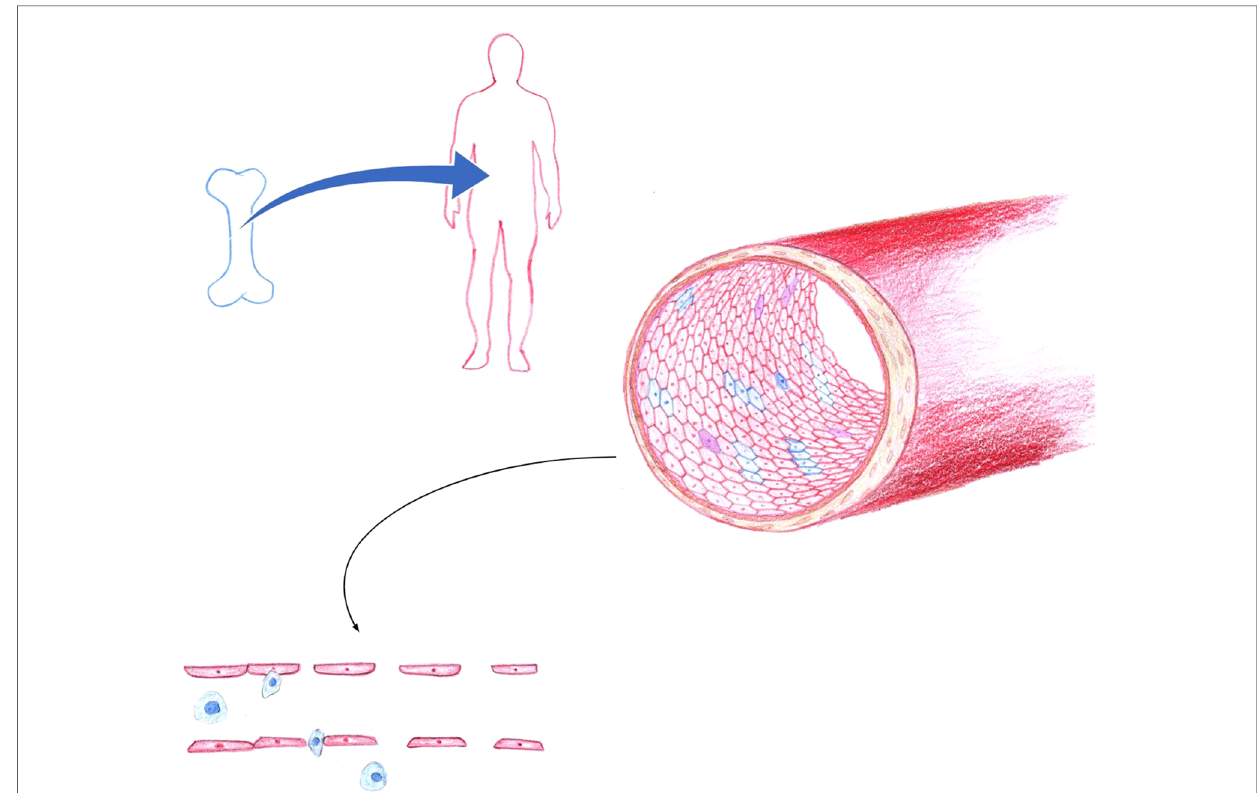
FIGURE 1 In hematopoietic stem cell transplantation, endothelial chimerism is a result of the process by which recipient endothelium is gradually repopulated by endothelial progenitor cells of donor bone marrow origin. Blue, indicates of donor origin. Red, indicates of recipient origin. Purple represents monocyte to endothelial transformation or fusion cell phenomena. Endothelial dysfunction is exacerbated by HLA and ABO disparity, along with loss of tight junction integrity, overexpression of adhesion molecules that promote leukocyte recruitment and transmigration across the endothelium. The resultant endotheliopathy contributes to the pathogenesis of graft versus host disease, sinusoidal obstruction syndrome, capillary leak, transplant associated thrombotic microangiopathy, and idiopathic pneumonia syndrome. (Figure by S.